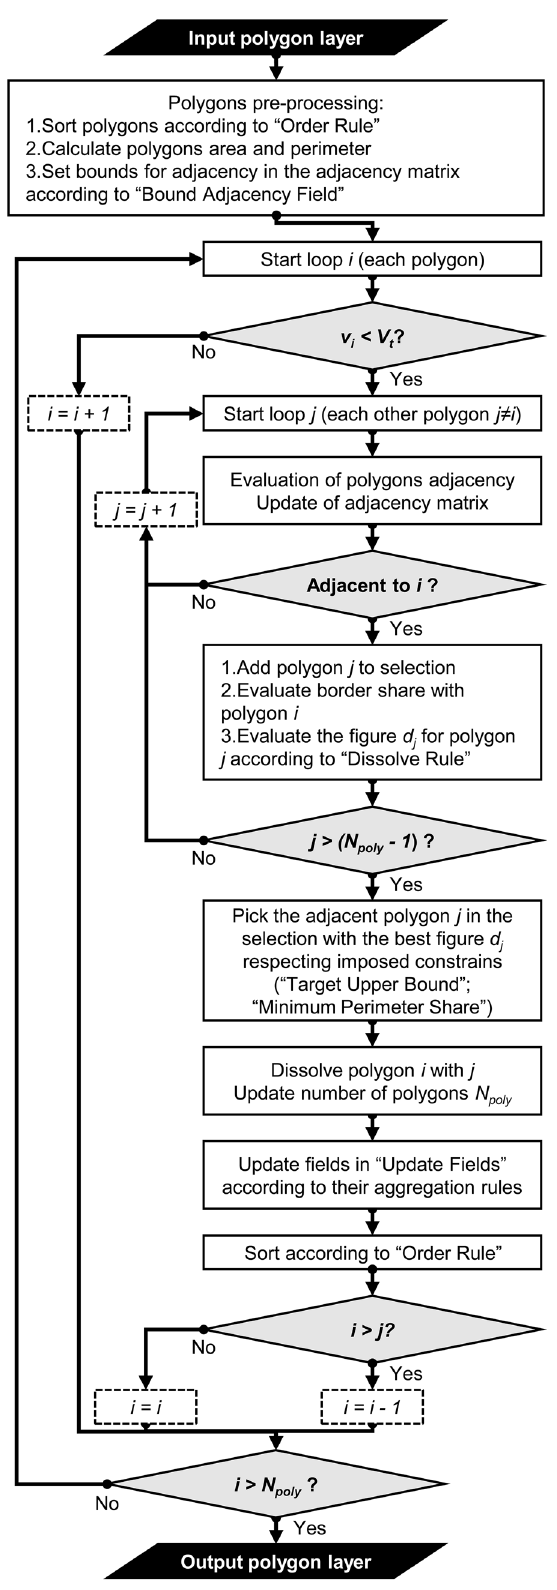
Figure 1. Aggregation algorithm flowchart: i is the external loop cursor (loop for testing target); j is the inner loop cursor (loop for adjacency test); V t is the user-defined threshold value of target field; v i is the value of target field for the current feature i ; d j is the objective value for each adjacent feature j to be maximized or minimized in the selection according to ‘Dissolve Rule’; Npoly is the total number of